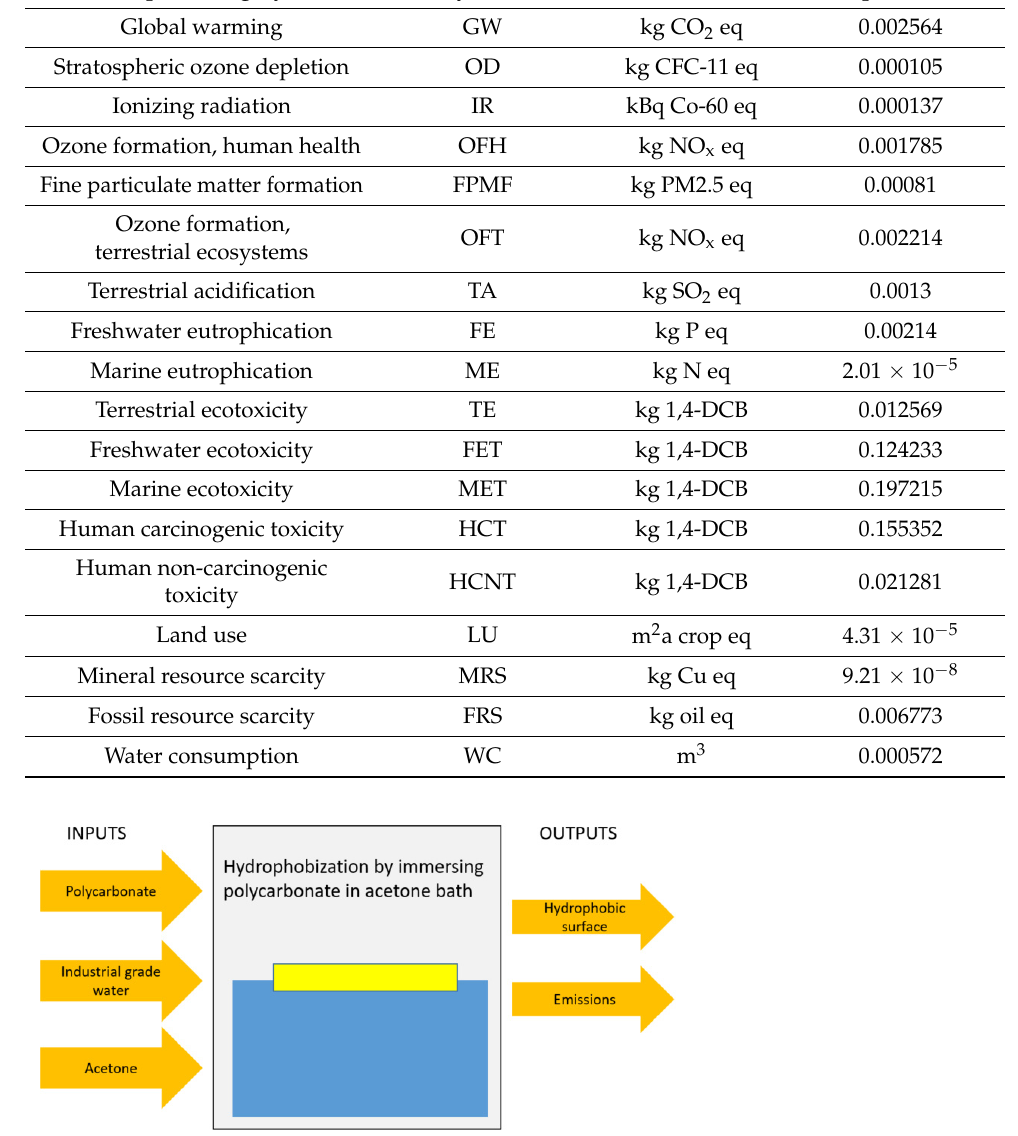
Figure 10. Boundary considered in life cycle analysis for hydrophobization of polycarbonate. Table 2. LCA results for hydrophobization of polycarbonate via solution crystallization while us- ing 30% acetone in the solution.